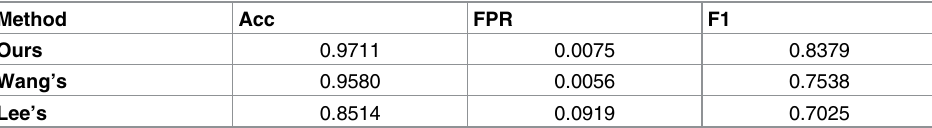
Table 9. Comparisons of different